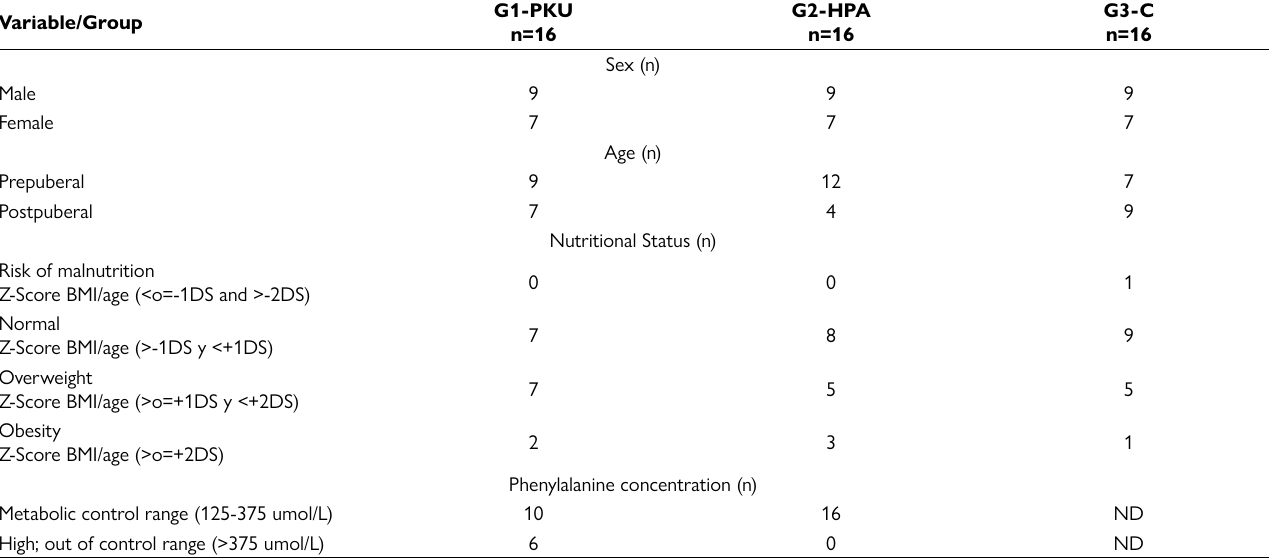
Abbreviations: The table represents the number of subjects per group. PKU: Phenylketonuria, HPA: Hyperphenylalaninemia, BMI: body mass index, ND: no